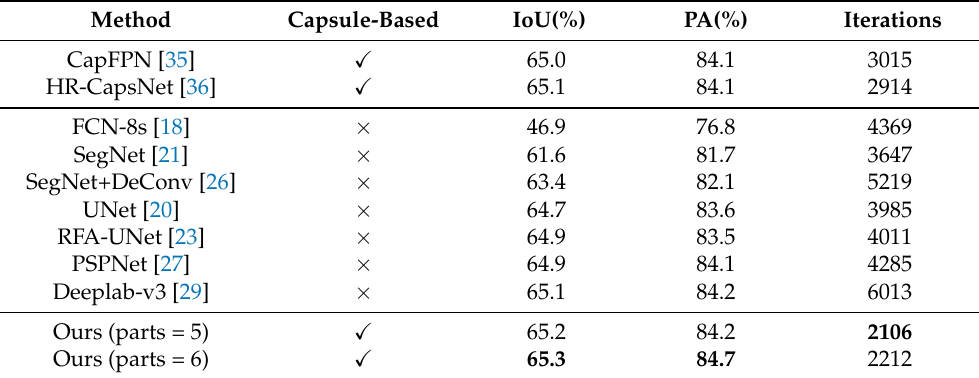
Table 3. Performance of different building extraction methods on the test